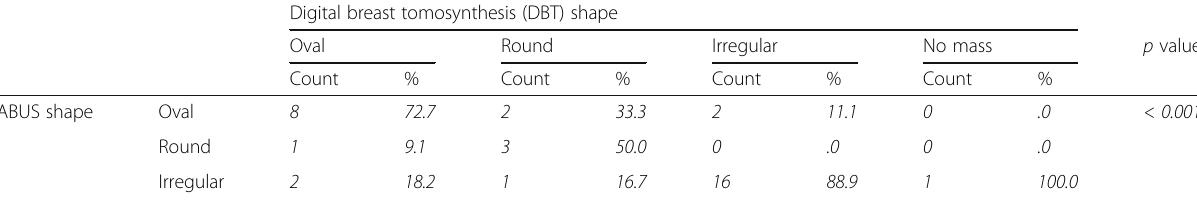
Table 2 Relation between both modalities regarding the shape Digital breast tomosynthesis (DBT) shape Oval